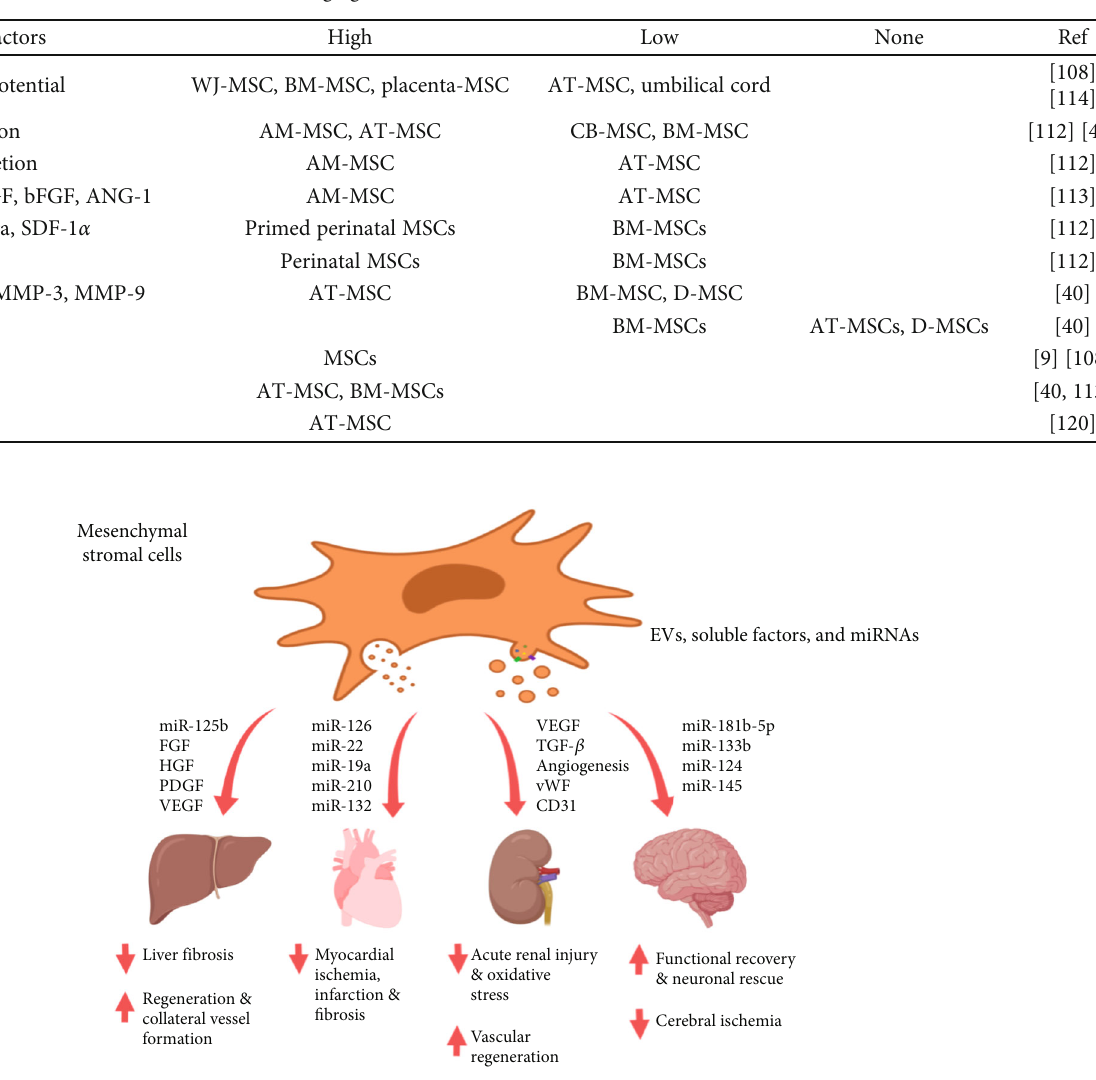
Table 2: Angiogenic secretome of MSCs from di ff erent sources.